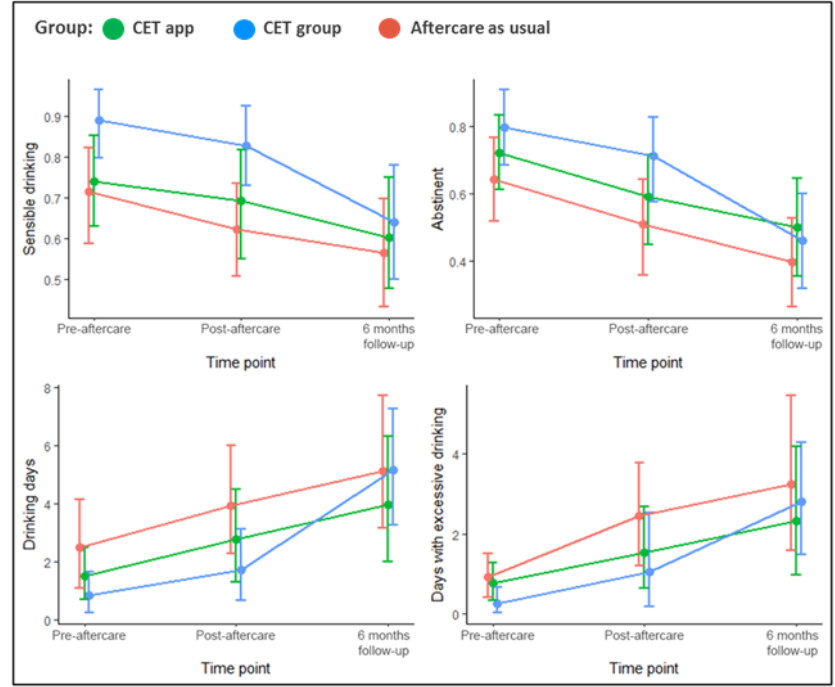
Figure 2. Primary outcomes by group allocation over time among individuals receiving cue exposure therapy (CET) as group aftercare or as a mobile phone app, or aftercare as usual.